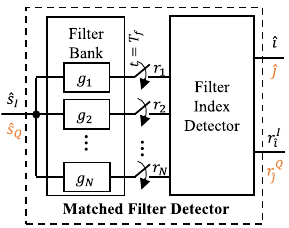
Fig. 2 Matched filter-based detector for IQ-FSIM. This block estimates the index ˆ ı ( ˆ  ) of the filter shape being used at I (Q) component using the input ˆ s I ( ˆ s Q